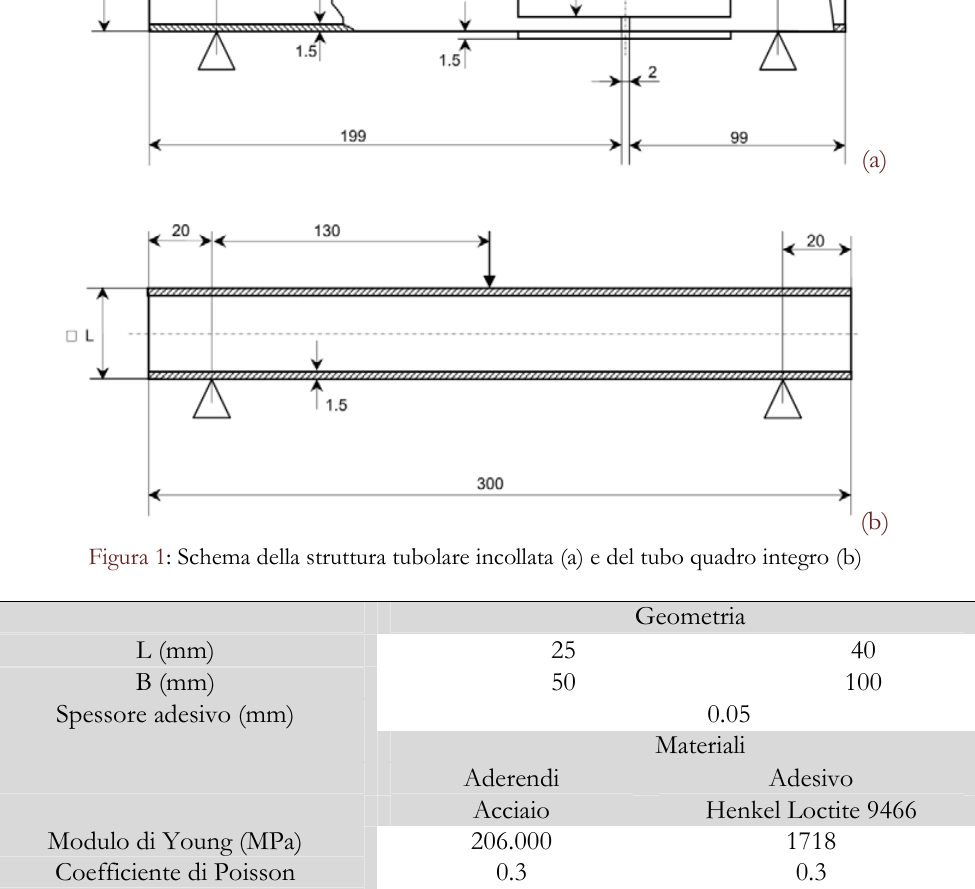
Tabella 1: Variabili geometriche e proprietà meccaniche